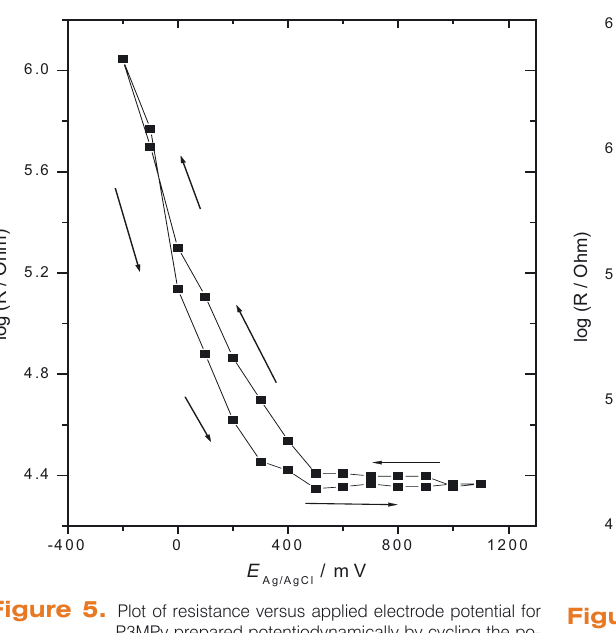
Figure 6. Plot of resistance versus applied electrode potential for poly(3MPy- β -DMCD) prepared potentiodynamically by < 1.10 V (from a cycling the potential (100 cycles) from -0.20 < E < Ag/AgCl Ag/AgCl ) 1.10 V (from a solution of 0.038 M poly(3MPy- β -DMCD) 4 . in acetonitrile + 0.05 M LiClO ) in a solution of acetonitrile 4 4 + 0.05 M LiClO .